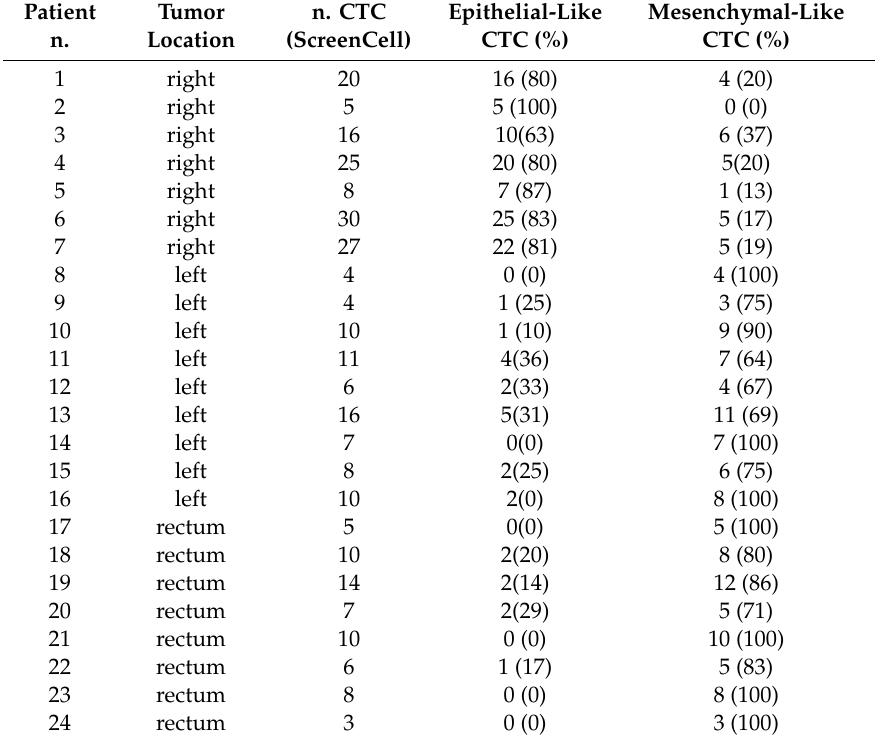
Table 2. Percentage of epithelial-like and mesenchymal-like CTC in right-sided cancers (RCC), left-sided cancers (LCC), and rectal